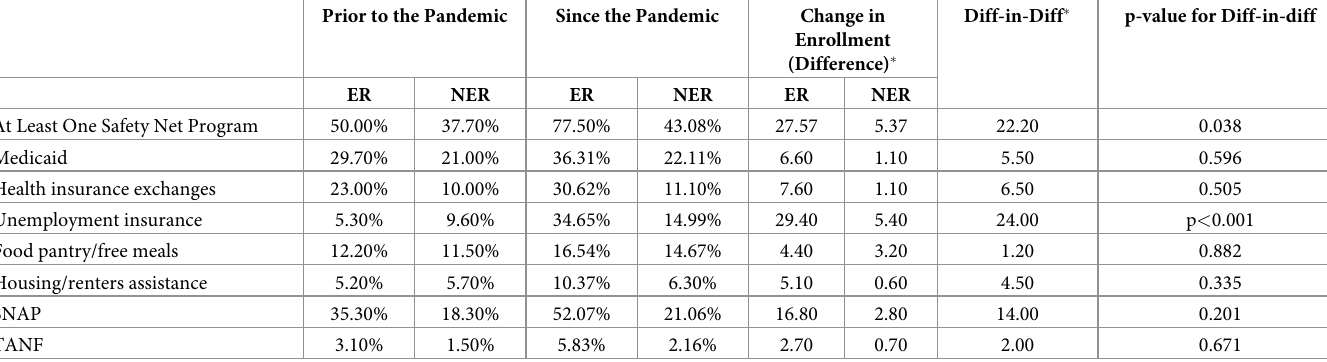
Table 4. Comparing changes in program participation among individuals who experienced employment reduction versus those who did